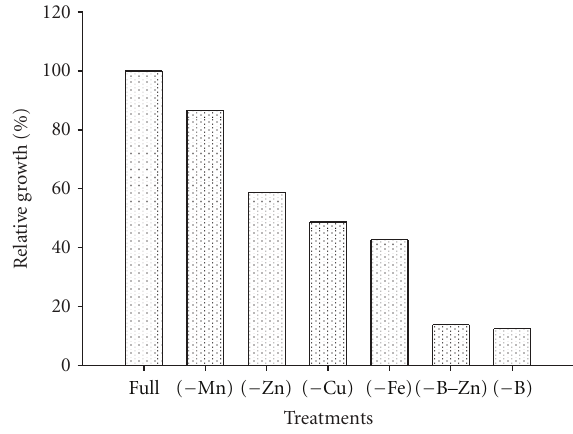
Figure 3: Relative growth (%) of Australian Red Cedar plants in relation to total dry matter yield of the full